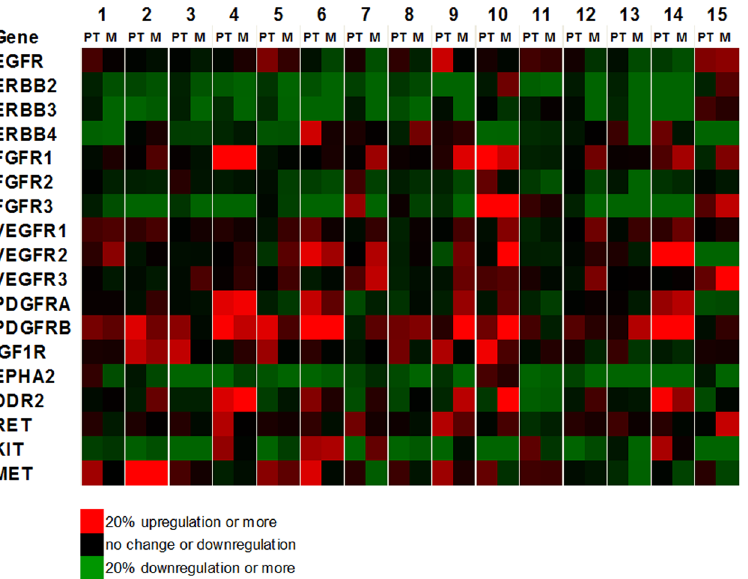
Figure 5. Comparison of Receptor Tyrosine Kinase (RTK) Expression of all patients. Differential expression values for selected genes were colour coded (bright red for an overexpression of ≥ 20%, bright green for a downregulation of ≥ 20%). In a ratio to their corresponding normal tissue mucosa, primary tumour values (PT) and metastasis values (M) are listed for each patient